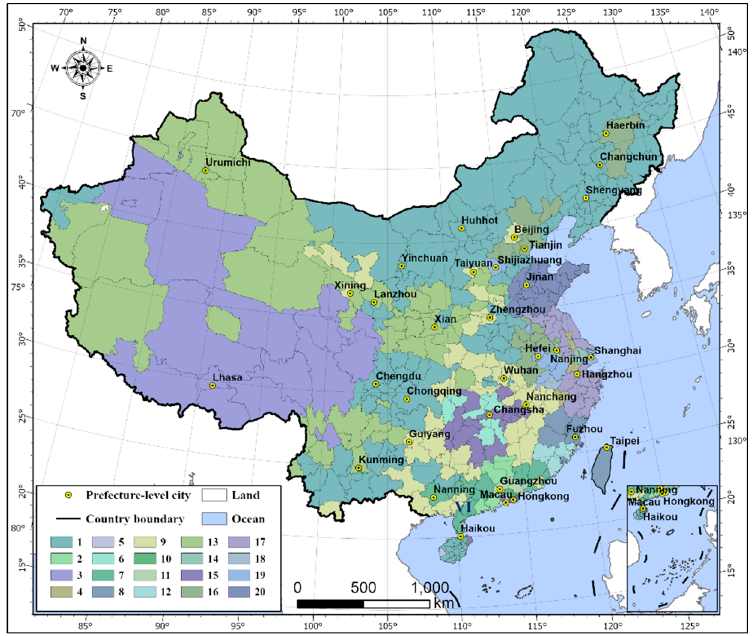
Figure 4. The classification result of prefectures based on cuisine preference.